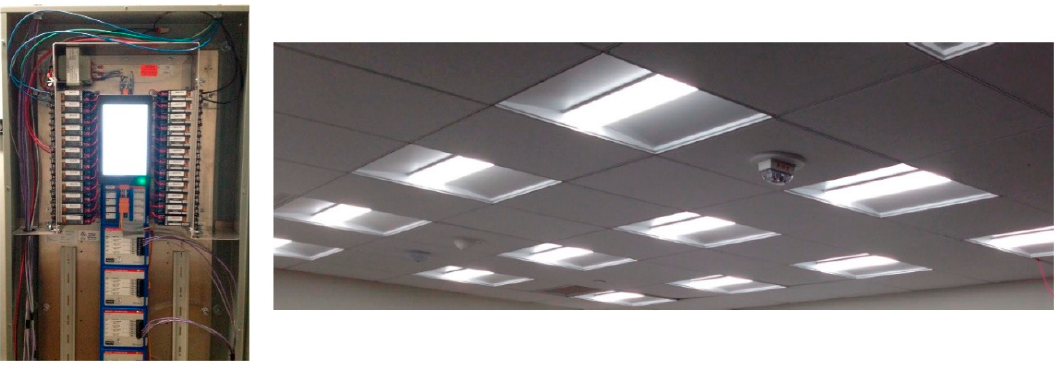
Figure 3. Photo of the lighting system controller ( left ) and lighting luminaires ( right ).